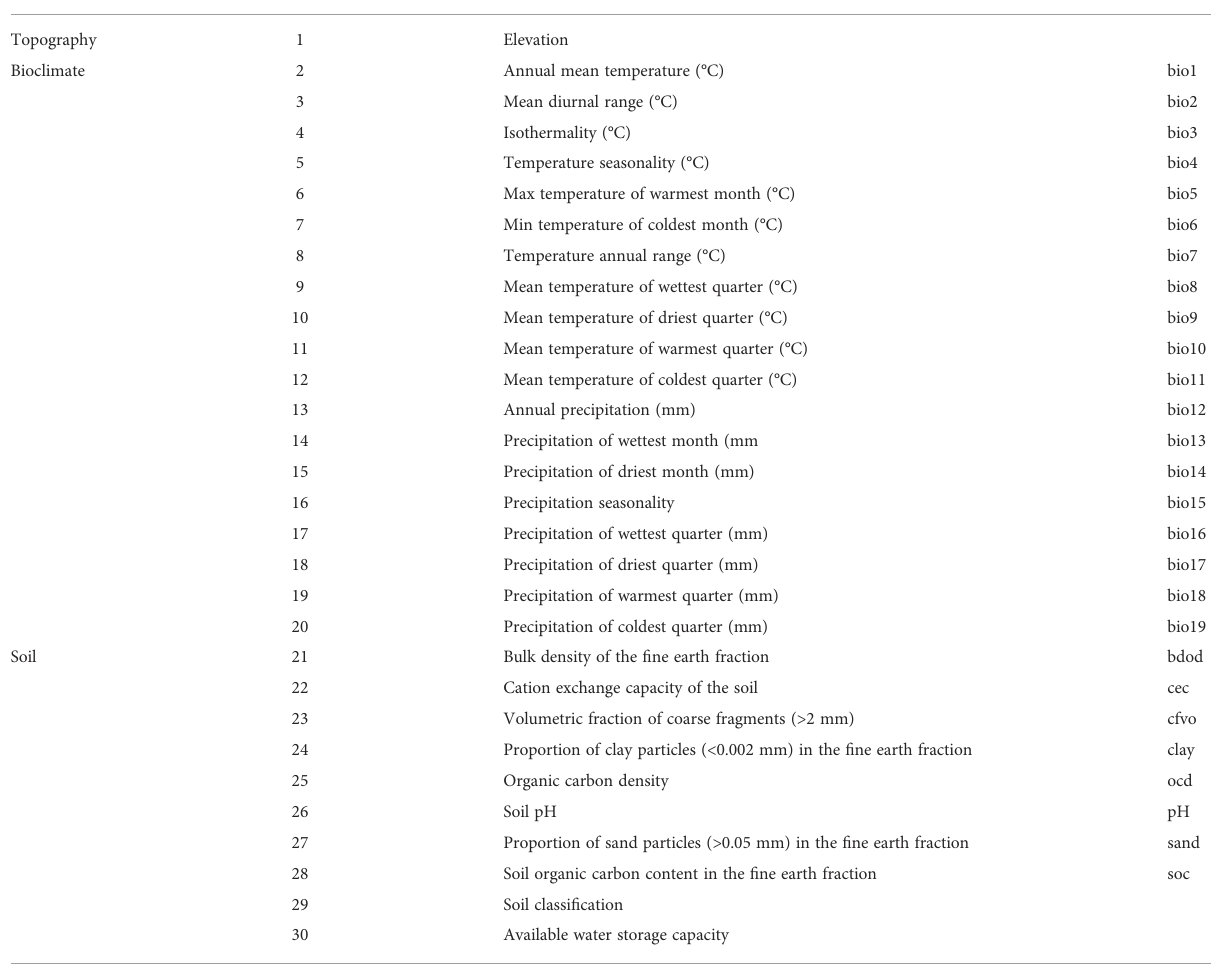
TABLE 1 Total environment